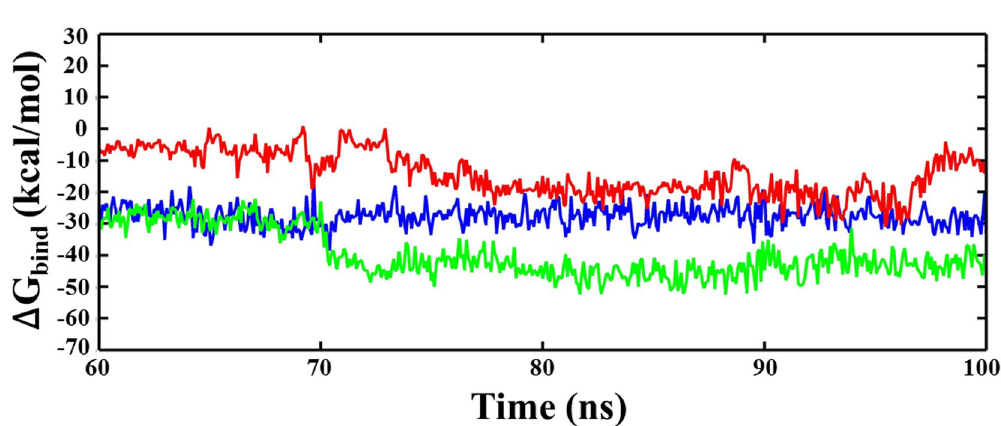
Figure 7. Binding free energy (ΔG bind ) estimation of ligands, NF1, NF12, and NF13 with ACE2, using MM-GBSA.